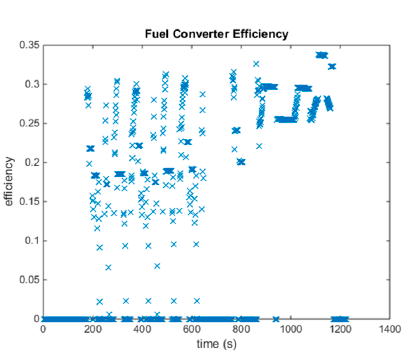
Figure 19. SOC history.